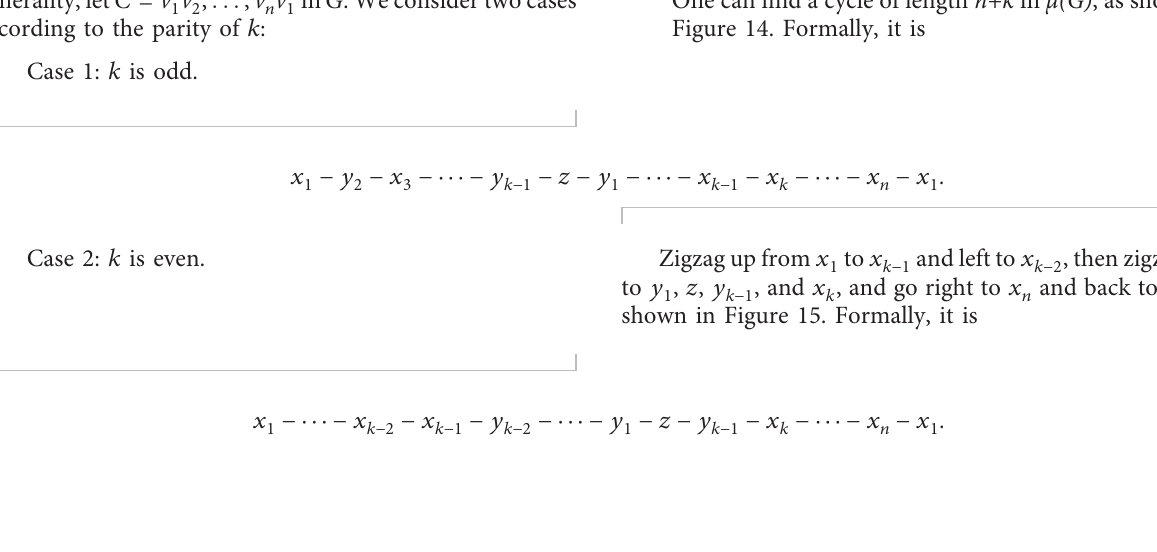
by type B insertion in GP ( 8 , 2 ) 8